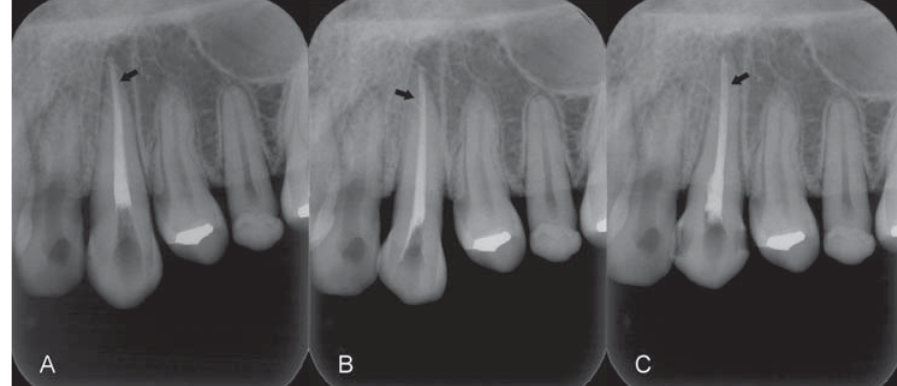
Figure 2- (cid:2)(cid:3)(cid:4)(cid:5)(cid:6)(cid:4)(cid:7)(cid:4)(cid:8)(cid:9)(cid:10)(cid:9)(cid:11)(cid:12)(cid:4)(cid:2)(cid:6)(cid:10)(cid:13)(cid:11)(cid:14)(cid:15)(cid:6)(cid:10)(cid:5)(cid:16)(cid:11)(cid:17)(cid:2)(cid:11)(cid:18)(cid:10)(cid:15)(cid:4)(cid:7)(cid:2)(cid:14)(cid:19)(cid:2)(cid:13)(cid:4)(cid:19)(cid:4)(cid:17)(cid:9)(cid:11)(cid:12)(cid:4)(cid:2)(cid:6)(cid:14)(cid:14)(cid:9)(cid:2)(cid:17)(cid:10)(cid:8)(cid:10)(cid:20)(cid:2)(cid:21)(cid:20)(cid:20)(cid:11)(cid:8)(cid:15)(cid:7)(cid:2)(cid:10)(cid:7)(cid:7)(cid:4)(cid:7)(cid:7)(cid:4)(cid:13)(cid:2)(cid:22)(cid:23)(cid:2)(cid:9)(cid:16)(cid:4)(cid:2)(cid:4)(cid:24)(cid:10)(cid:18)(cid:11)(cid:8)(cid:4)(cid:6)(cid:7)(cid:2)(cid:25)(cid:26)(cid:2)(cid:27)(cid:2)(cid:26)(cid:28)(cid:2)(cid:29)(cid:20)(cid:30)(cid:7)(cid:31)!(cid:2) B – Acroseal ® ; C – Non-radiopaque sealer). Note the appearance of simulated voids (arrows)